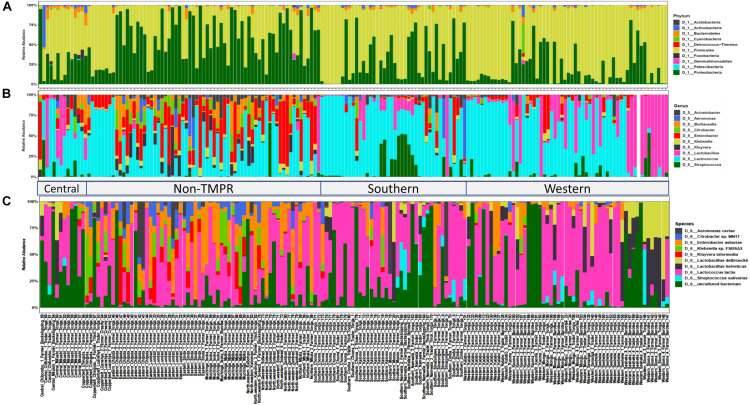
Bacterial community composition of the top 10 relative abundant bacteria in mabisi at the level of: (A) phylum, (B) genus, and (C) species. Each bar represents an individual sample. Two main regions are shown the traditional mabisi production region (TMPR) represented by Western, Southern and Central provinces, and the non-TMPR.